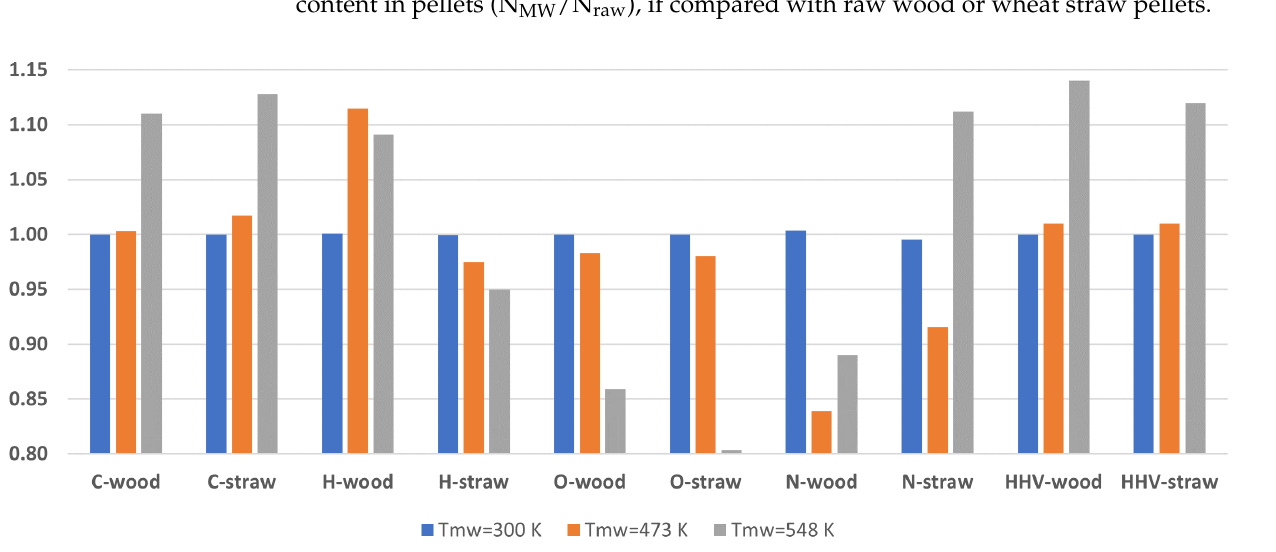
Table 1. Proximate composition and higher heating value (HHV) of commercial wood, wheat straw, and peat pellets (on dry basis).